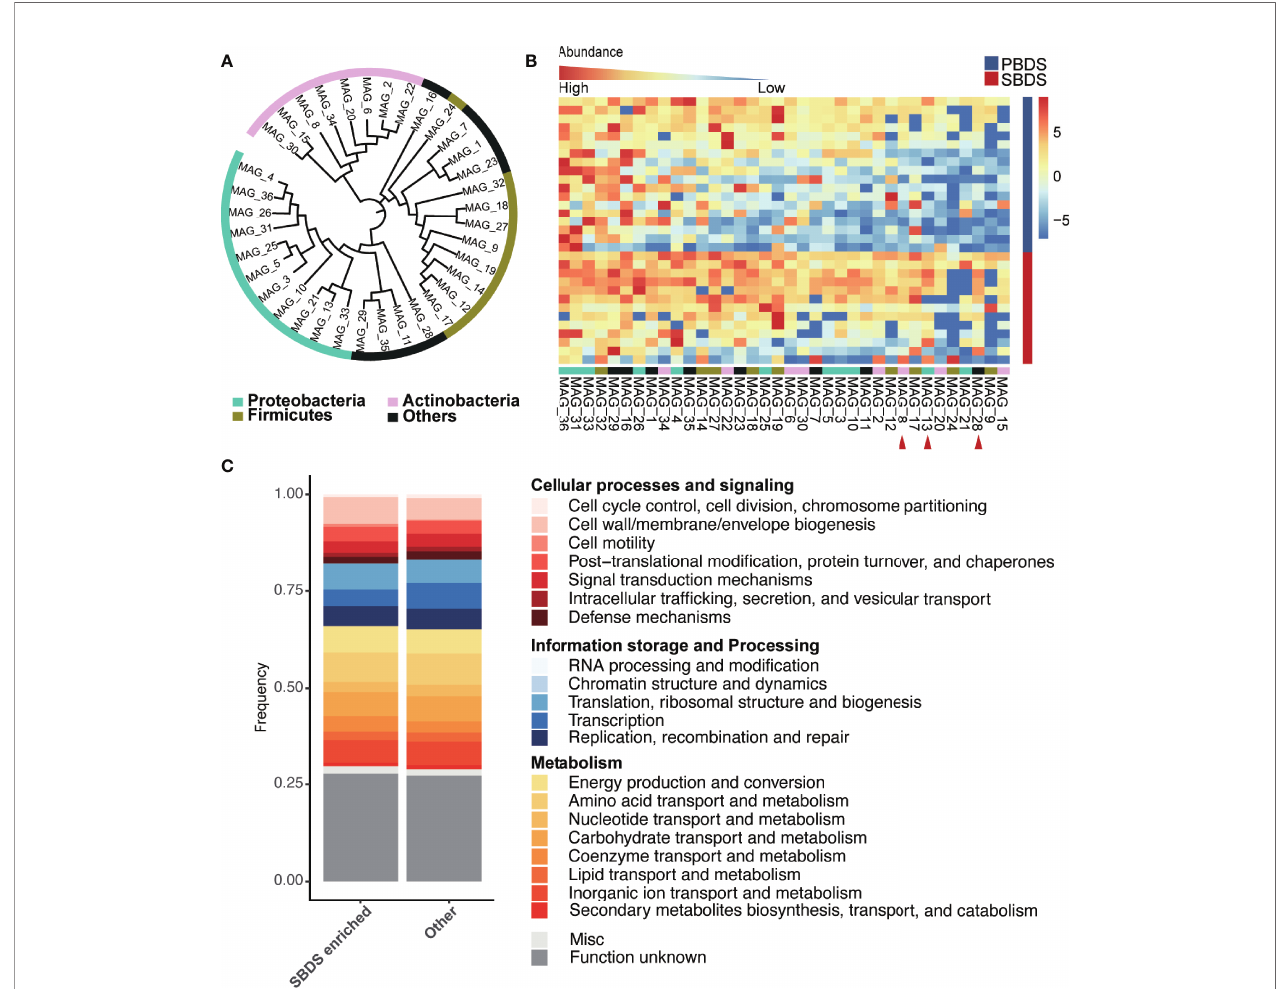
FIGURE 4 | Taxonomic and functional analysis of the MAGs. (A) The taxonomic tree of the MAGs, annotated at the phylum level. The tree was generated using PhyloPhlAn and visualized by interactive tree of life (iTOL) webserver (https://itol.embl.de/). (B) Relative abundance of the MAGs in the SBDS and PBDS samples, ordered by their average relative abundances, the red arrow points to the MAGs with signi fi cantly higher relative abundance in SBDS (Wilcoxon test; p < 0.05). (C) COG pro fi les of the SBDS enriched MAGs and other MAGs. MAGs: metagenomically assembled genomes; COG, clusters of orthologous group; PBDS, primary bile duct stone; SBDS, secondary bile duct